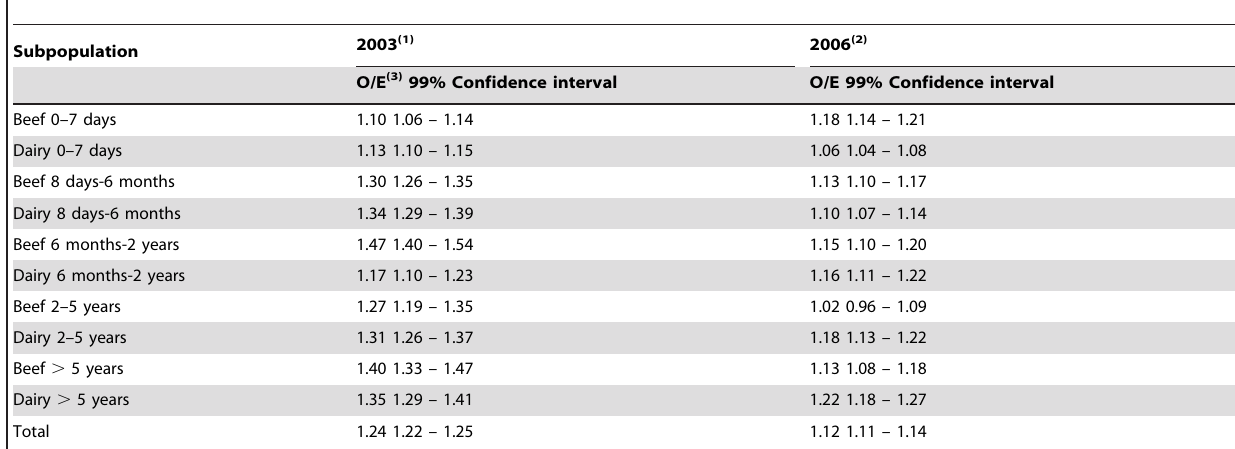
Table 2. Cumulated excess mortality by cattle subpopulation during the 2003 and 2006 heat waves in